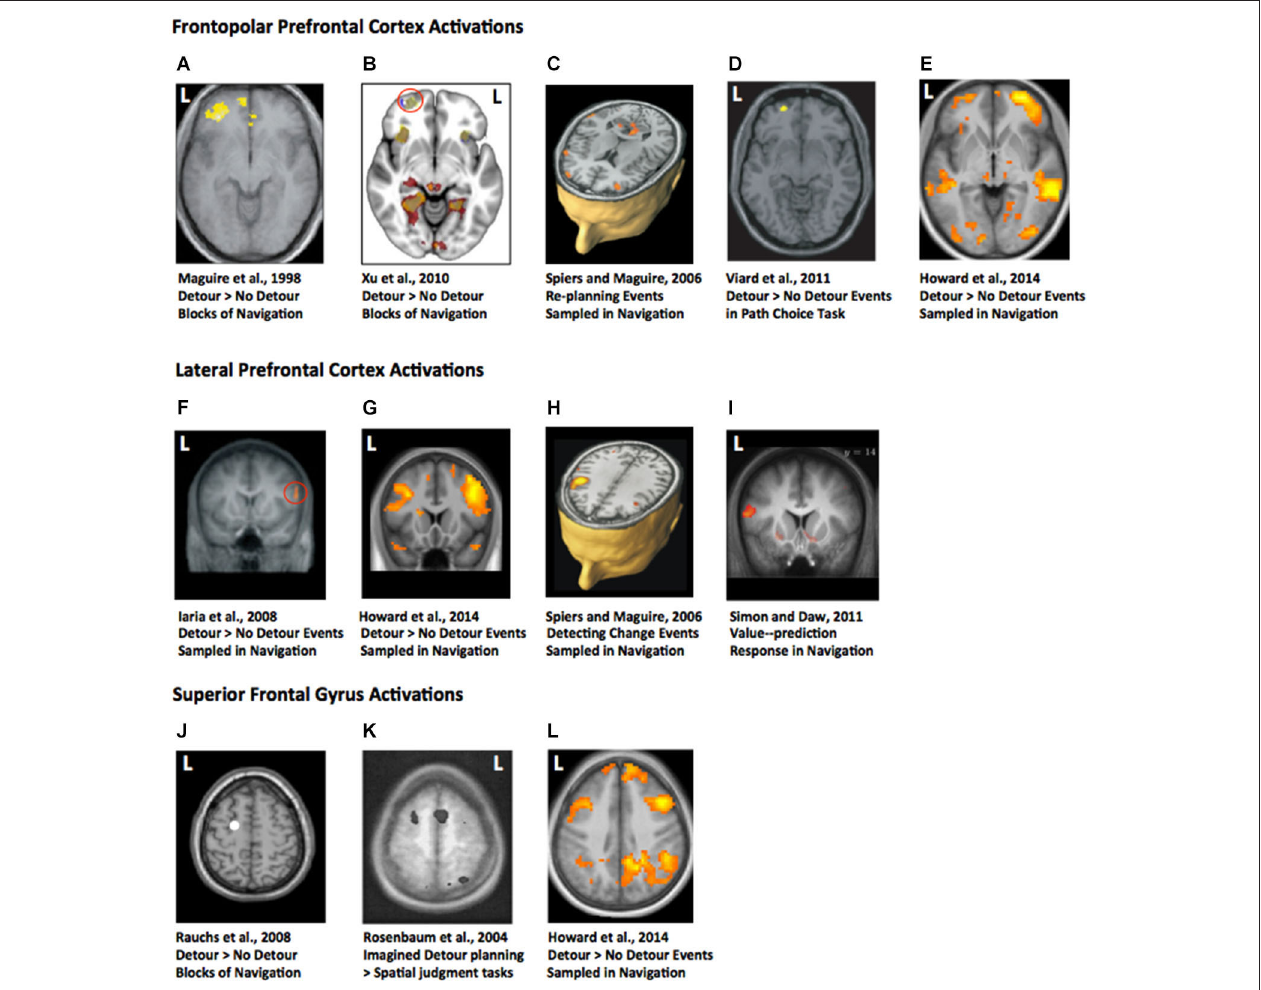
a detour condition than a no-detour condition, or responsive to value prediction (Simon and Daw, 2011). (J--L) Superior frontal gyrus active more in a detour than control conditions. Images adapted from the articles cited under the images with permission. Image in (J) shows a coronal section of the canonical T1 image from SPM8 with a white marker indicating the location of the peak coordinate in the left frontal gyrus activation reported by Rauchs et al.